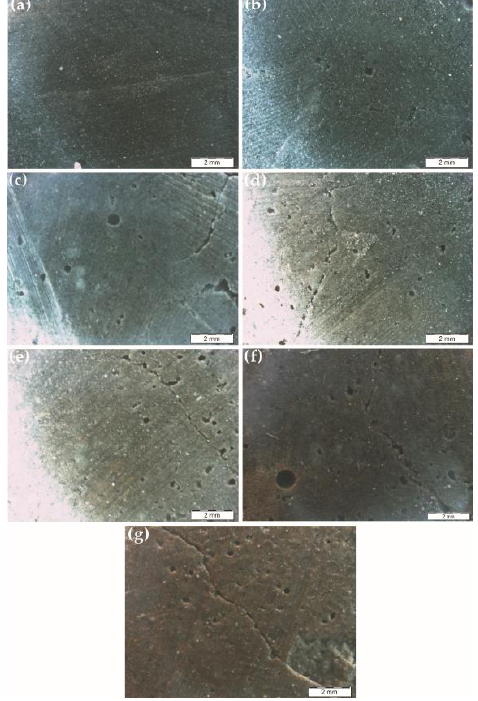
Figure 10. Images of the section of the 200 °C-heated samples after being immersed in water for 24 h: ( a ) the image of the control; ( b ) 0%; ( c ) 2%; ( d ) 4%; ( e ) 6%; ( f ) 8%; ( g ) 10%.